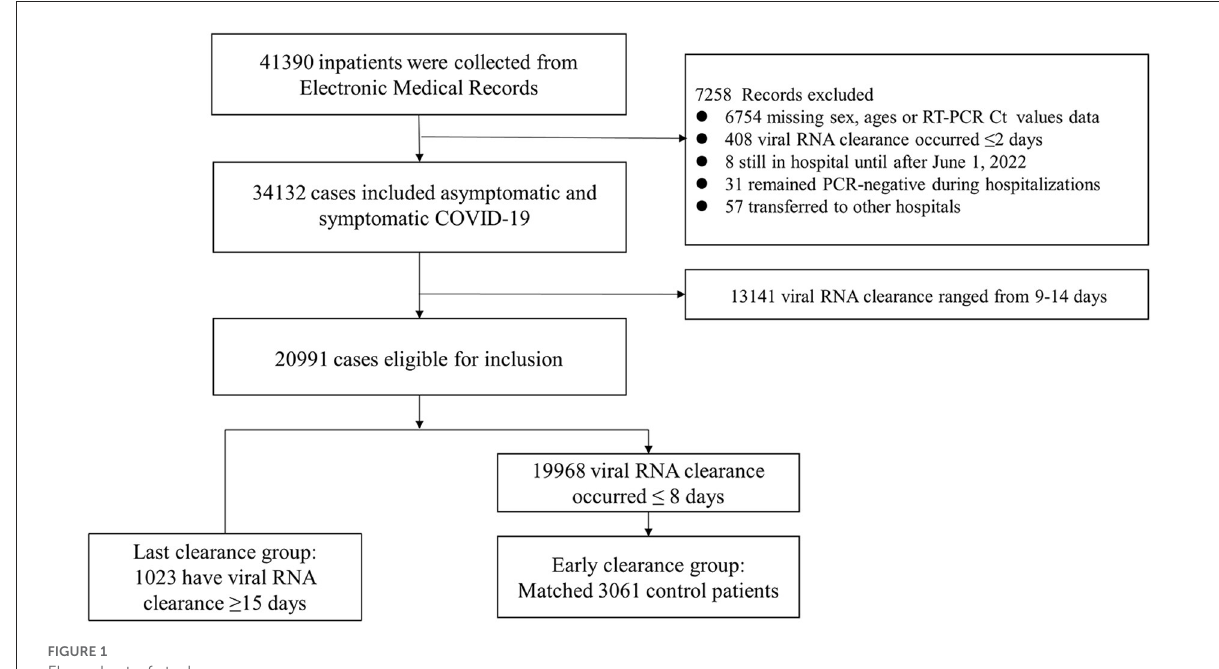
FIGURE1 Flow chart of